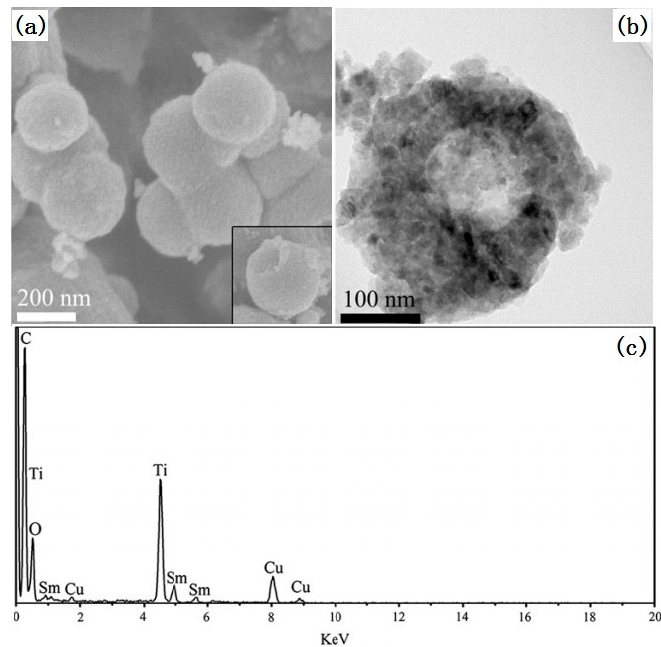
Figure 3. ( a ) SEM image, ( b ) TEM (Transmission Electron Microscopy) image and ( c ) EDS (Energy Dispersive Spectrum) of TiO 2 :Sm 3+ hollow spheres [29].